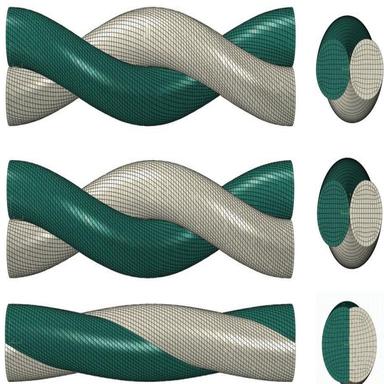
RVE models of helical carbon fiber tows.